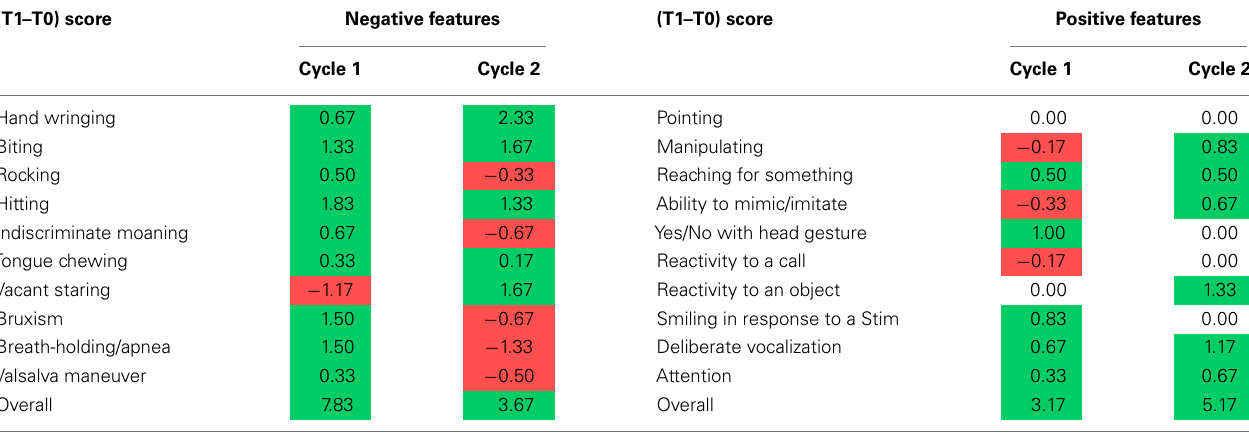
Table 5 | Differential scores of social and cognitive abilities during cycles . (T1–T0)